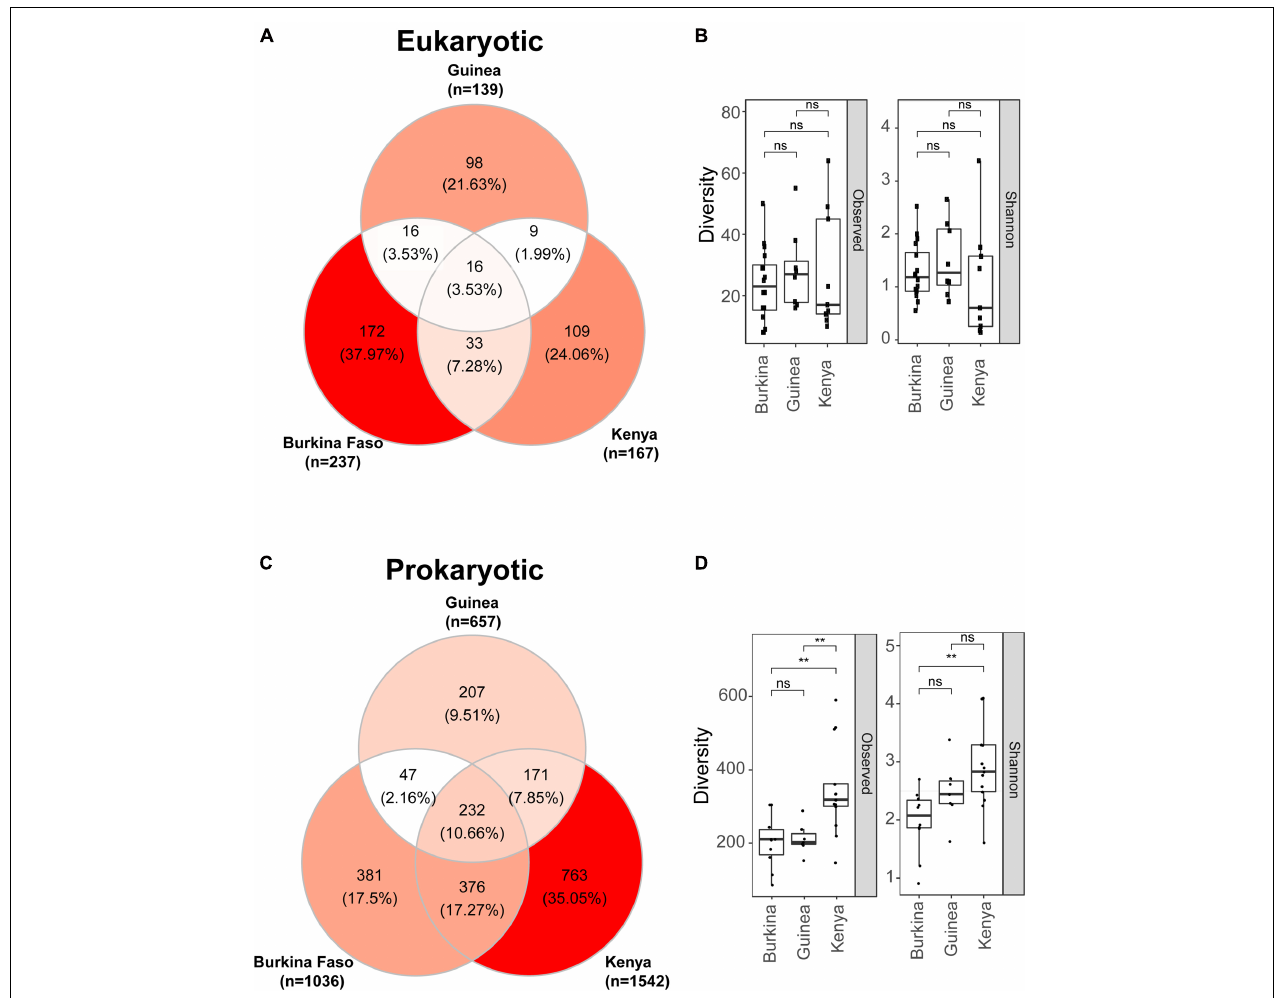
FIGURE 4 | Eukaryotic microbes detected in mosquito larvae are more unique to the geographic location of collection than prokaryotic microbiomes where individuals OTUs are more often detected in mosquito larvae from at least two locations. (A) Venn diagram depicting the number of eukaryotic OTUs detected in DNA pools of mosquito larvae across Burkina Faso, Guinea and Kenya. (B) Eukaryotic microbiome diversity as a function of geographic origin shown as both observed OTUs (left) and Shannon diversity (right). There is no significant difference in eukaryotic diversity as a function of country of origin; ns = non-significant, p > 0.05. For these box plots the upper and lower bounds of the box indicate the third and first quartiles, respectively, and the line within the box indicates the median. Whiskers extends to the largest values no further than 1.5 time the inter-quartile range from the corresponding upper and lower bounds of the box. All individual data points are shown as individual dots. (C) Venn diagram depicting the number of prokaryotic OTUs detected in DNA pools of mosquito larvae and shared across Burkina Faso, Guinea and Kenya. (D) Prokaryotic microbiome diversity as a function of geographic origin shown both as observed OTUs (left) and Shannon diversity (right). Shannon diversity takes into account both richness and evenness while Observed diversity considered only richness. Mosquito larvae sampled in Kenya have significantly greater prokaryotic diversity measured by either metric, **, p ≤ 0.01. Box plots as in